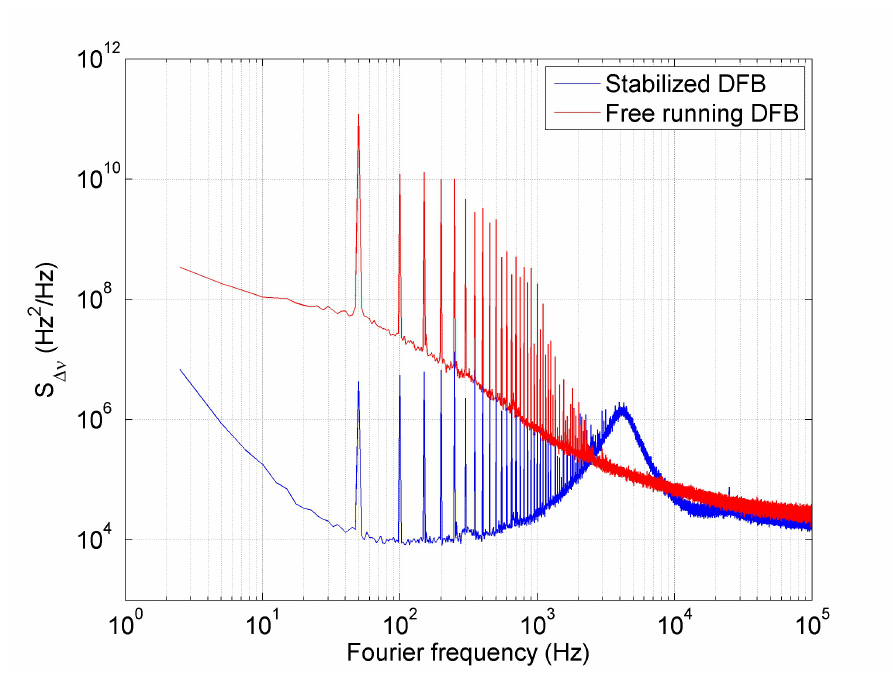
Figure 3. In-loop power spectral density of the frequency noise calculated from the RF spectrum measured on RF spectral analyzer Agilent N9000A (see RFSA in Figure 1).